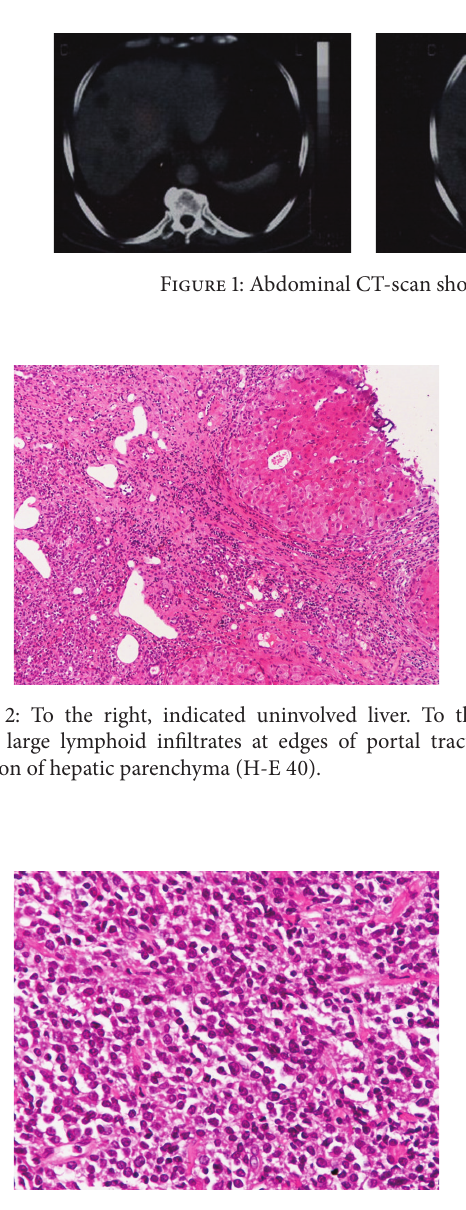
Figure 3: Uniform population of lymphoid cells of large size with many mitotic figures (H-E 400).